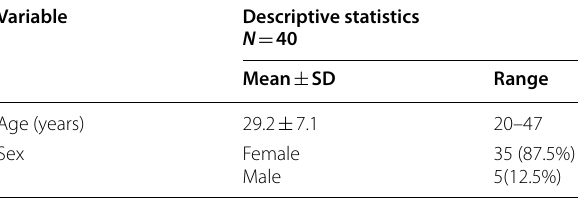
Table 1 Socio-demographic data among 40 MS patients: Table 2 Socio-demographic data among 20